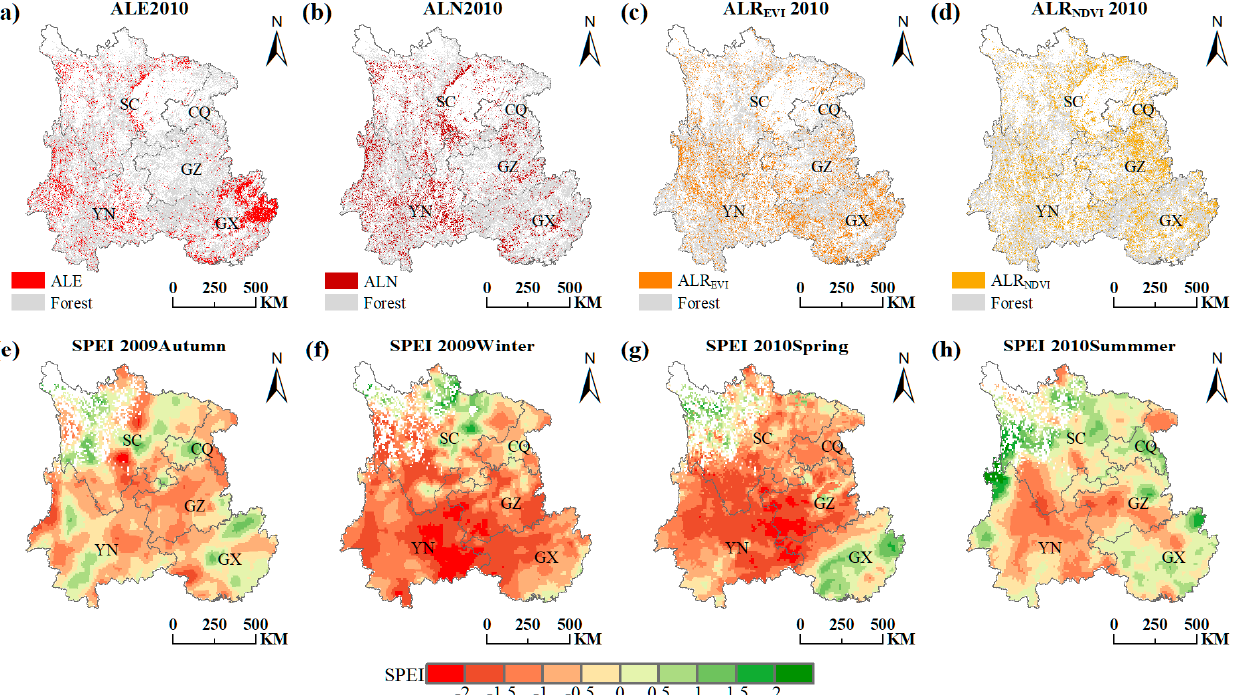
Figure 5. Spatial pattern of the ALE in 2010 ( a ), ALN in 2010 ( b ), ALR EVI in 2010 ( c ), ALR NDVI in 2010 ( d ), the 2009 autumn drought ( e ), the 2009 winter drought ( f ), the 2010 spring drought ( g ) and the 2010 summer drought ( h ) across Southwest China. The abbreviation: CQ (Chongqing), SC (Sichuan), GZ (Guizhou), YN (Yunnan) and GX (Guangxi).